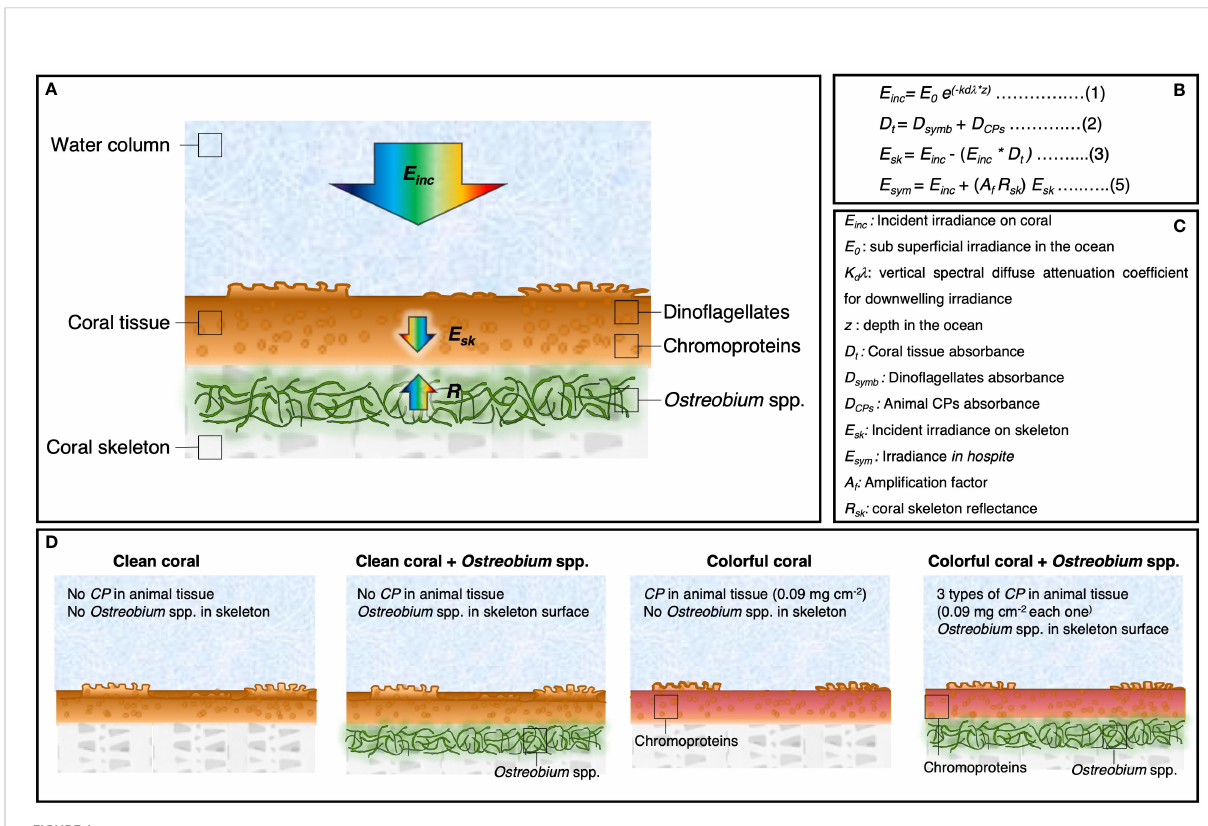
FIGURE 1 Description of the numerical model for light absorption in corals. (A) Schematic representation of the coral model. Arrows indicate the parameters used to determine the light environment in hospite for the symbionts. (B) Equations used in the numerical model for the calculation of (1) the incident irradiance on the coral, (2) the coral tissue absorbance, (3) the incident irradiance in the skeleton, and (5) and the light environment in hospite for the symbionts. (C) Description of the variables used in the model. (D) Different scenarios of light absorption in corals: a clean coral with a white skeleton (no chromoproteins, no Ostreobium spp.), clean coral with an Ostreobium spp. bloom near the skeletal surface, a colorful coral with one of the three chromoproteins upregulated in the tissue: asulCP562, amilCP580, or amilCP604 (0.09 mg cm -2 ), and a colorful coral with an Ostreobium spp. bloom near the skeletal